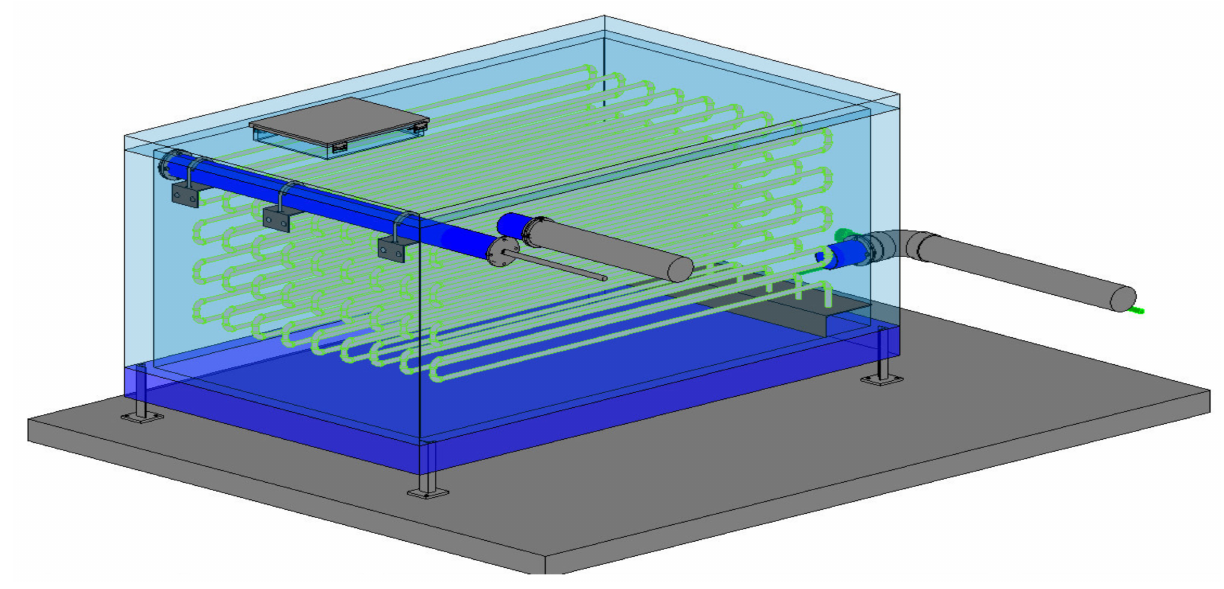
Figure 1. Design model of cold storage tank.